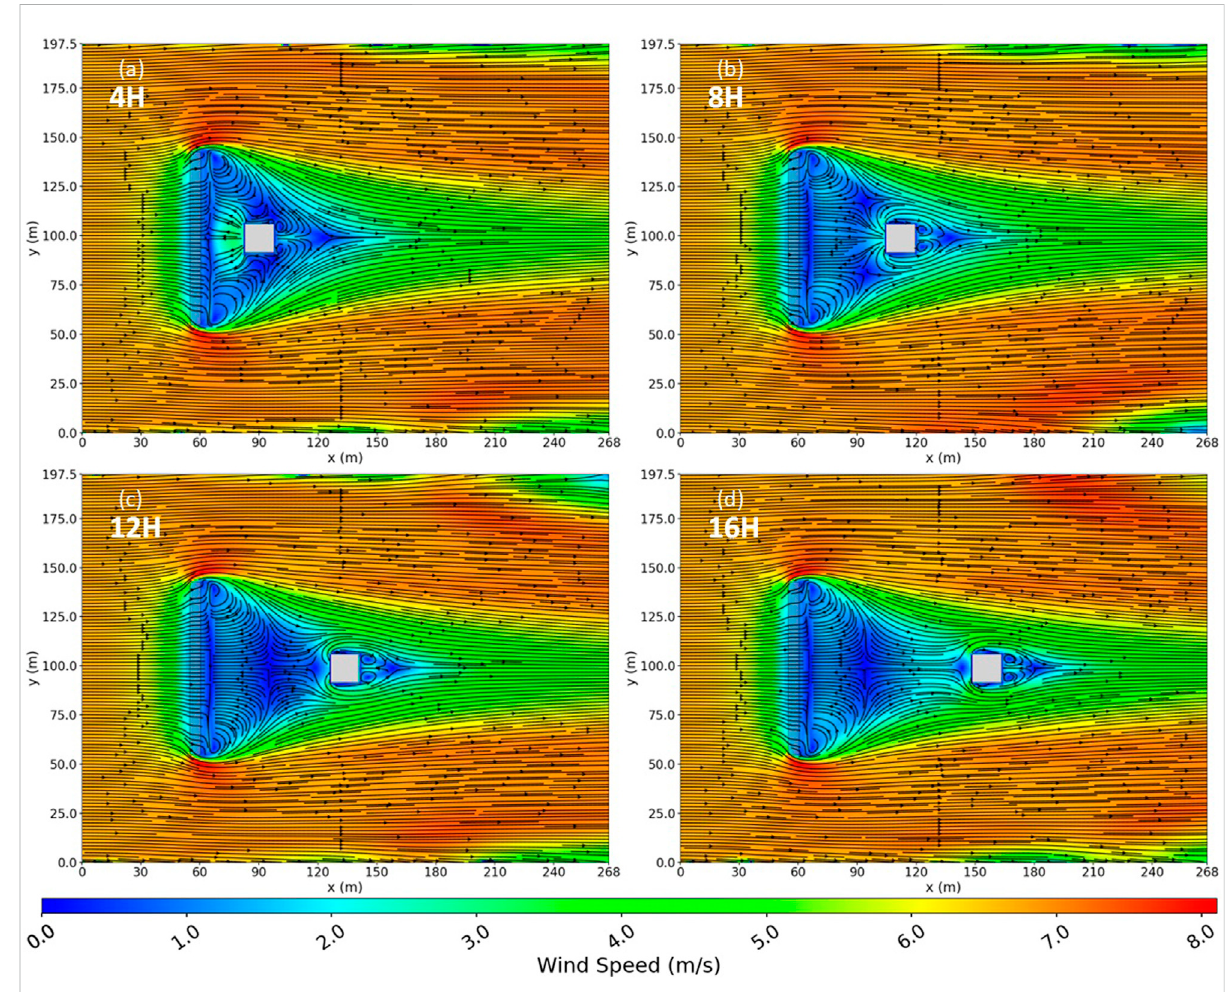
FIGURE 4 Top view slice at z = 1.4 m of the resulting wind fi elds with avegetation fence and house included in thedomain. The house isplaced at various distances downwind of the vegetation fence in (A – D)